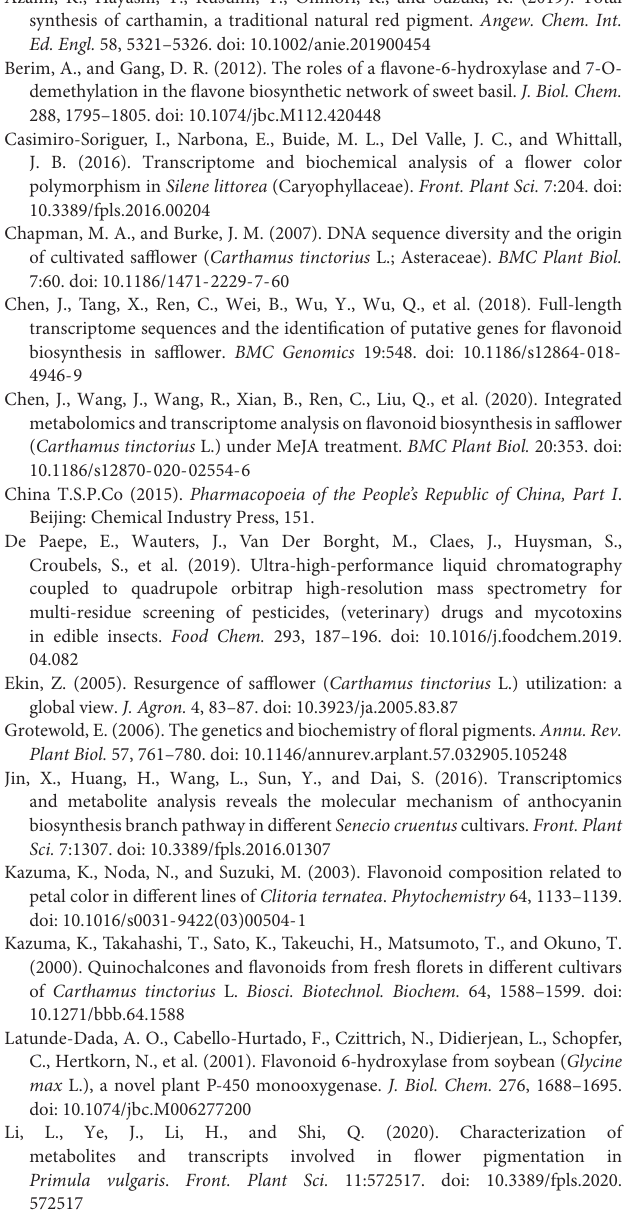
Supplementary Table 3 | Differential flavonoid metabolic species among the different color flower of safflower. Supplementary Table 4 | Details of all the gene annotation. Supplementary Table 5 | Details of all the different expression genes. Supplementary Table 6 | Details of the different expression of flavonoid biosynthesis genes in the four different color flowers of safflower. Supplementary Table 7 | Details of the target genes and the candidate genes for the biosynthesis of